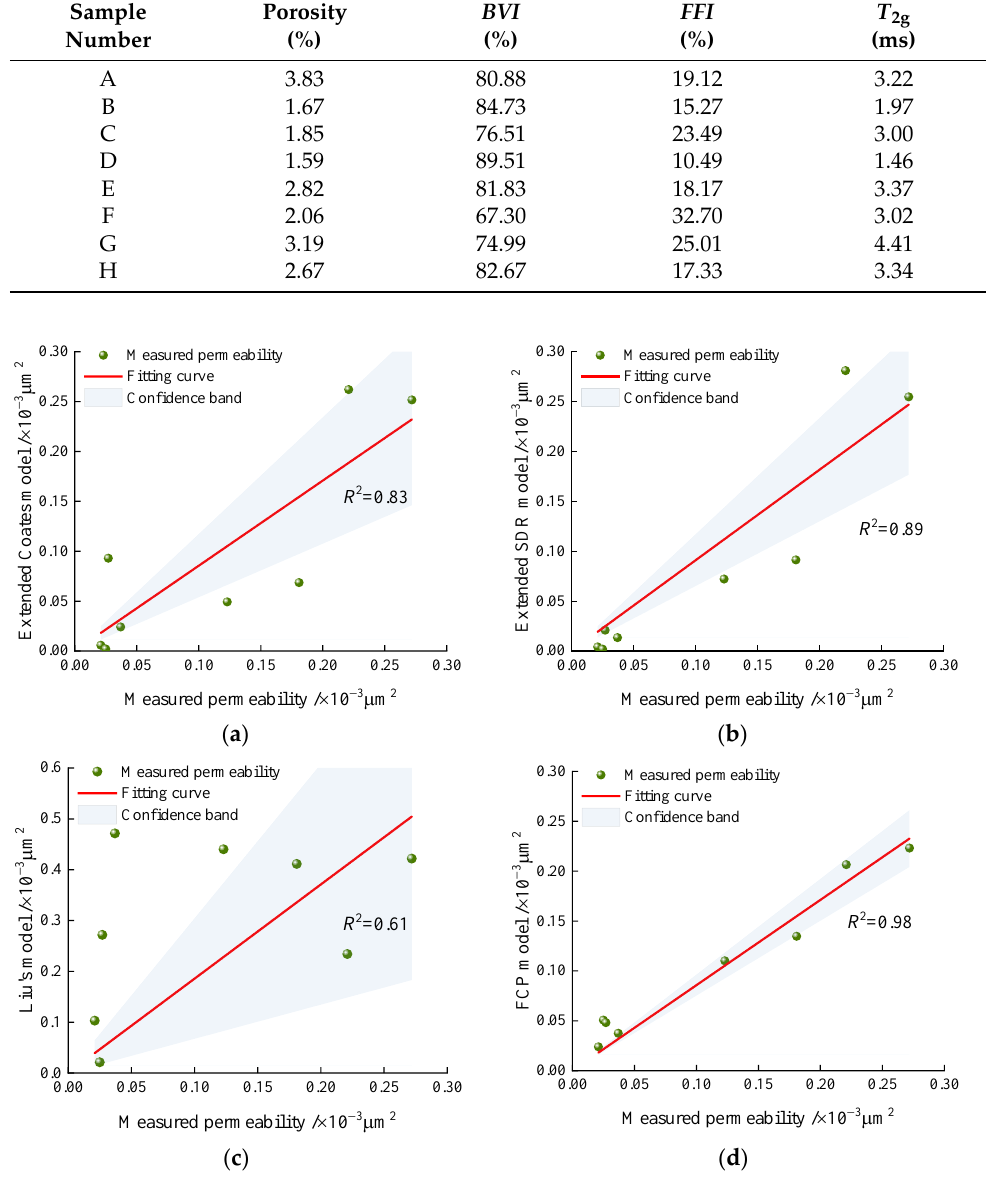
Figure 11. Predicted permeability values versus measured permeability: ( a ) extended Coates model; ( b ) extended SDR model; ( c ) Liu’s model; ( d ) FCP model.